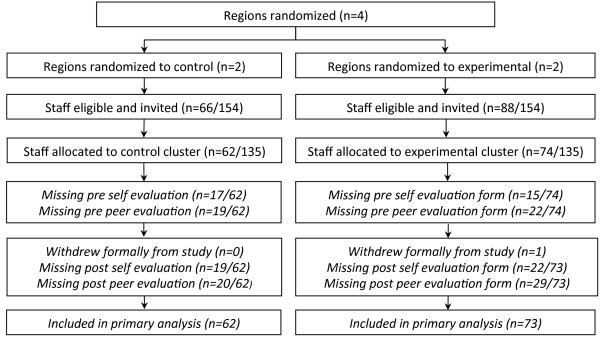
Participant flow diagram for RCT – from randomisation to primary analysis.